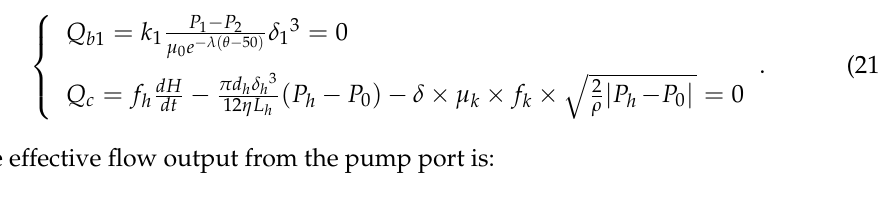
B 7 Figure 8. Schematic diagram of the dead zone pressure building experiment. 1: servomotor; 2: positive displacement pump; 3: pressure gauge; 4: solenoid directional valve; 5.1/5.2: check valve; 6: accumulator; 7: flow sensor. The A cavity of the positive displacement pump is closed by electromagnetic direc- tional valve 4. At this time, the speed is gradually increased, and the maximum pressure that cavity A in the positive displacement pump can reach is recorded. When the system pressure remains unchanged, the flow generated by the positive displacement pump is